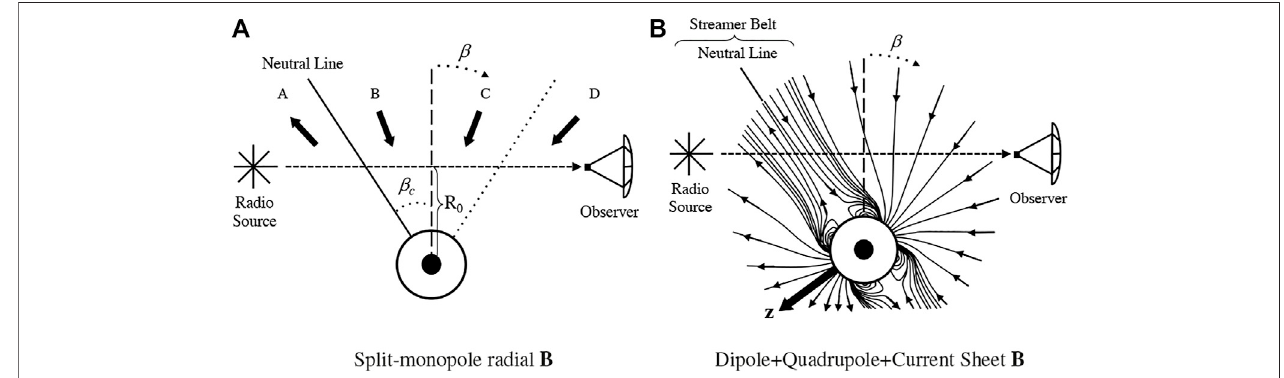
FIGURE 1 | Illustrations of coronal magnetic fi eld geometries. In (A) , the solid arrows give the orientation of magnetic fl ux on either side of the neutral line. R 0 is the impact parameter (i.e.wheretheLOS passesclosesttotheSun)and β c isthelocationatwhichtheLOS crossestheneutralline(with + β inthedirectionoftheobserver). The sectors A, B, C, and D represent regions of symmetry de fi ned bythe position of β c . Forthe Dipole + Quadrupole + Current Sheet (DQCS) model in (B) , there isstill a neutral line de fi ned by the current sheet with positive or negative fl ux on either side; however, the corona is no longer separated into symmetric sectors. The solid arrowgivesthez-axisorientationasde fi nedinBanaszkiewiczetal.(1998).LeftimageappearsasFigure1inKooietal.(2014),©AAS,reproducedwithpermission.Right image appears as Figure 4 in Kooi and Kaplan (2020), ©Springer, reproduced with